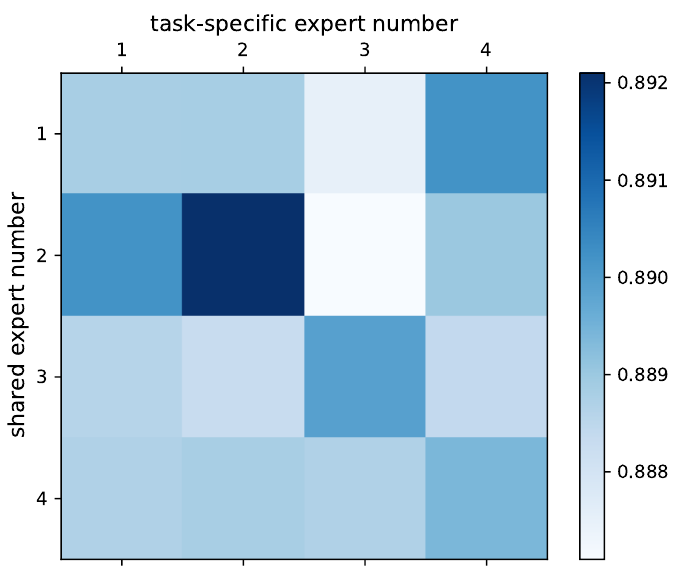
Figure 3. Pear mean value of model with different number of Experts, where the darker color indicates a higher Pear value.